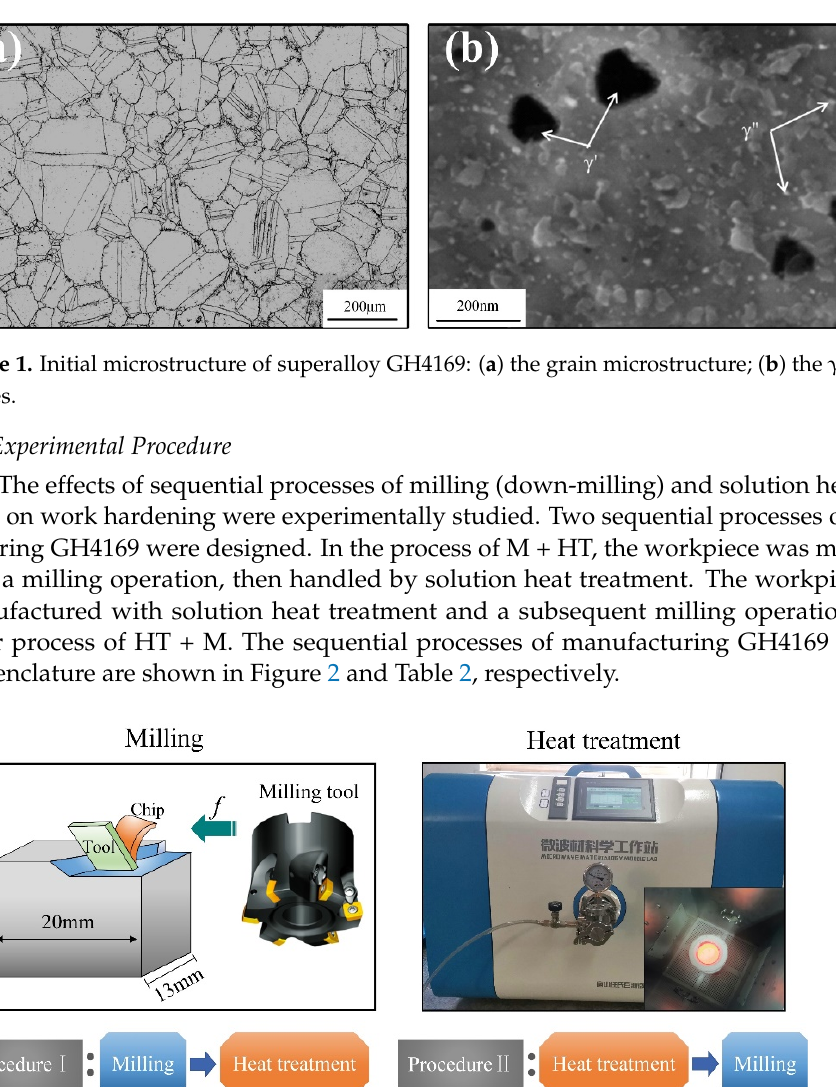
Table 1. Chemical composition of as-received GH4169 (wt.%).